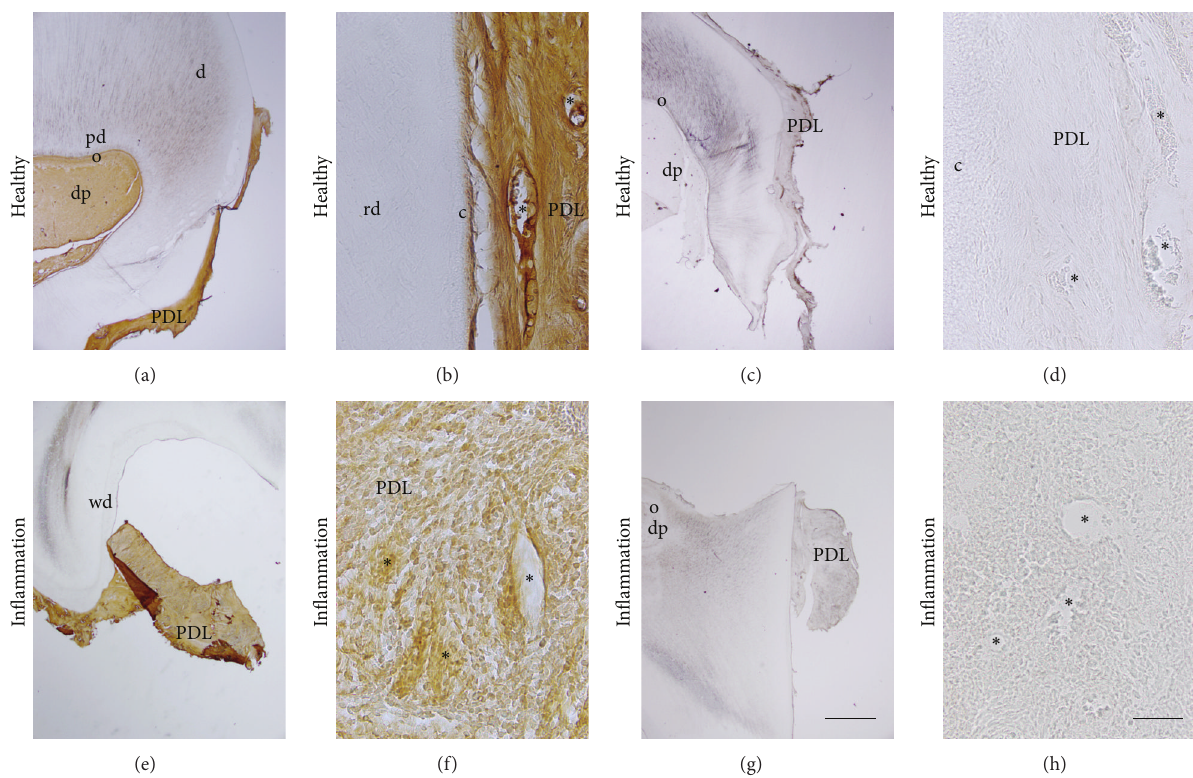
Figure 1: Localization of RCAN1 in healthy and chronically inflamed periodontal ligament (PDL). d = dentin, pd = predentin, o = odontoblasts, dp = dental pulp, rd = reactive dentin, PDL = periodontal ligament, and c = cementum. Asterisks indicate blood vessels (b) or negative erythrocytes indicating blocked endogenous peroxidase in blood vessels (d). Bars: (a, c, e, g) 1mm; (b, d, f, h) 50 𝜇 m.